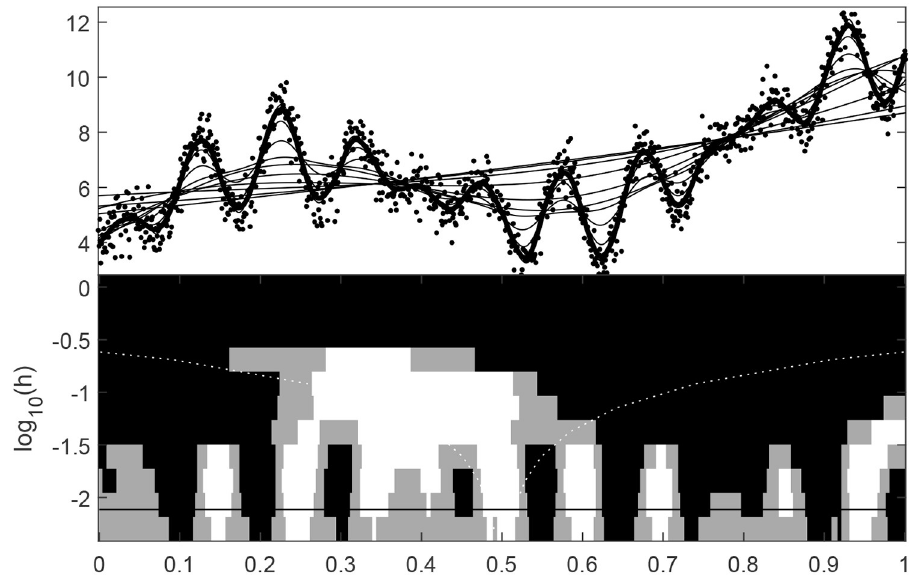
Fig 1. SiZer map of artifical data. The upper panel shows the artifical values as dots and a set of smoothed curves with different smoothing bandwidths. The solid line, which is very close to the true underlying signal, corresponds to a computer-chosen optimal bandwidth. In the lower panel, the vertical axis corresponds to, from top to bottom, wider to narrower smoothing bandwidths (the horizontal line corresponds to the computer-chosen optimal bandwidth). White and black pixels correspond to significant decrease and increase, respectively. Gray pixels correspond to situations where the background signal can be assumed constant.